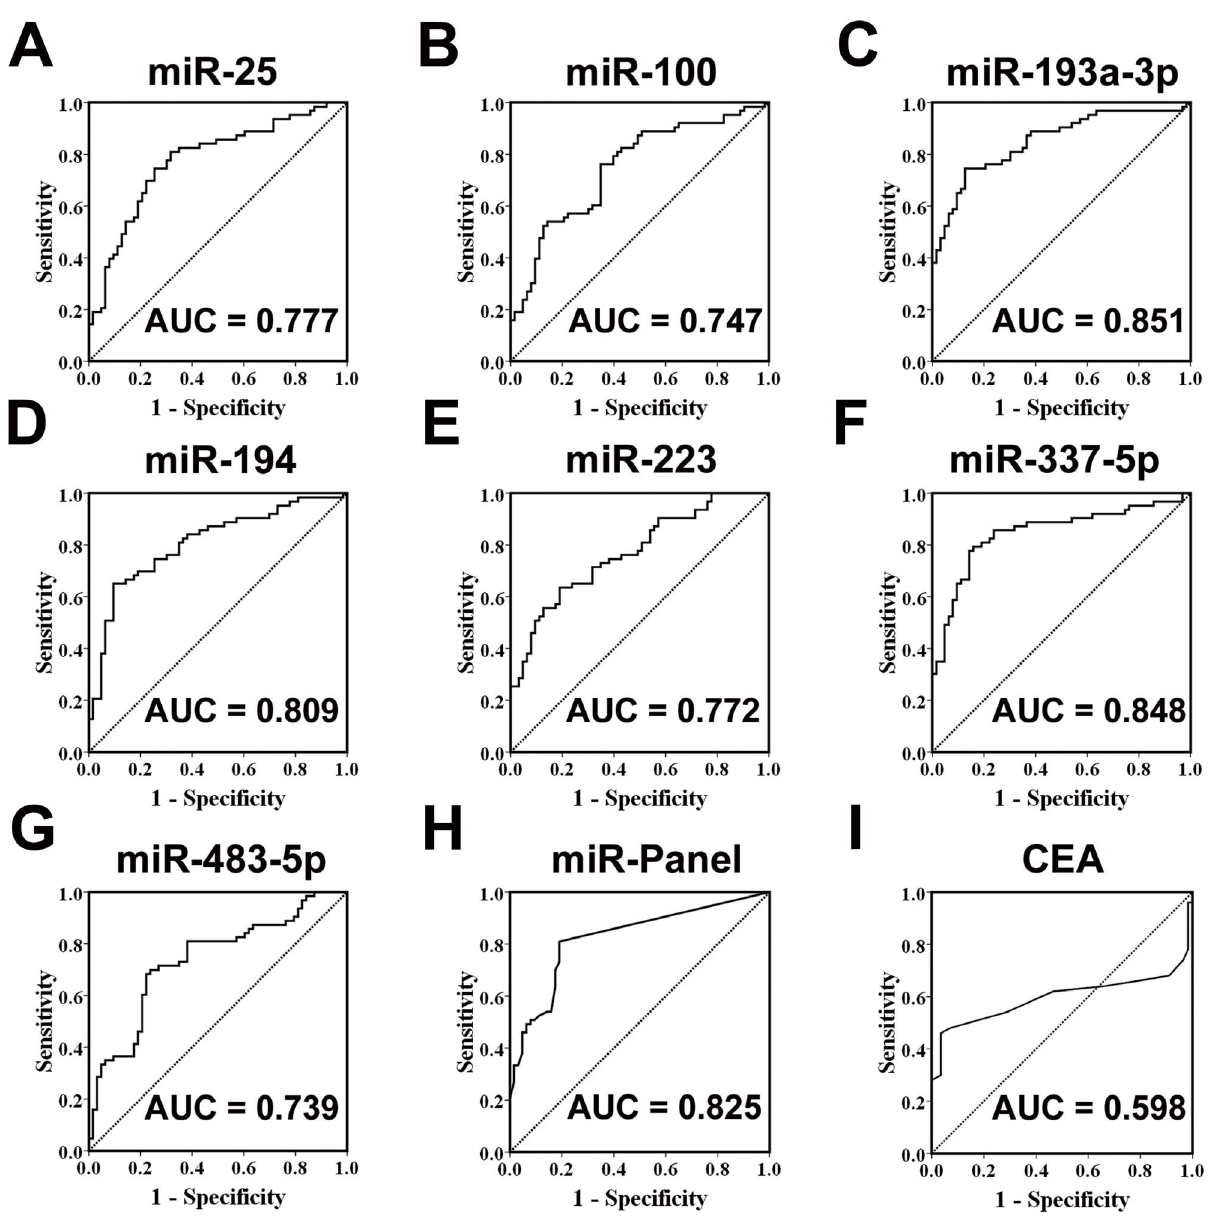
Figure 3. ROC curves to compare the ability of miRNA to distinguish oesophageal squamous cell carcinoma (ESCC) from the normal controls. (A) miR-25, (B) miR-100, (C) miR-193-3p, (D) miR-194, (E) miR-223, (F) miR-337-5p, (G) miR-483-5p, (H) the seven-miRNA panel and (I) carcinoembryonic antigen (CEA).